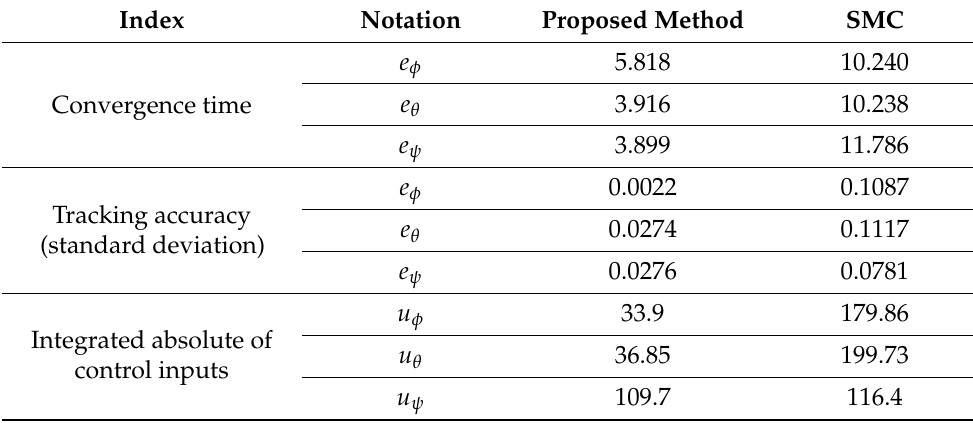
Figure 8. Comparison of control inputs between proposed method and SMC. Table 4. Contrastive outcomes between proposed method and SMC [33] in simulations.